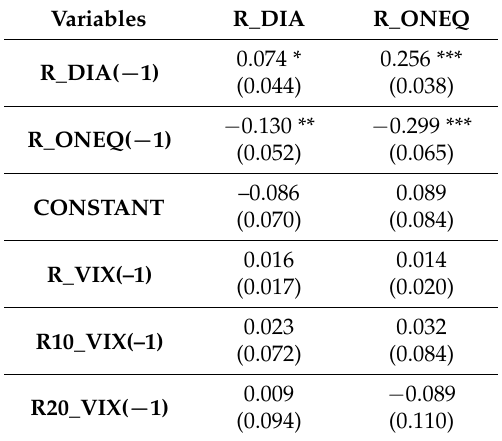
Table 20. Mean Equation for US Market ETF and VIX (During GFC) (1 November 2007 to 31 March 2009).